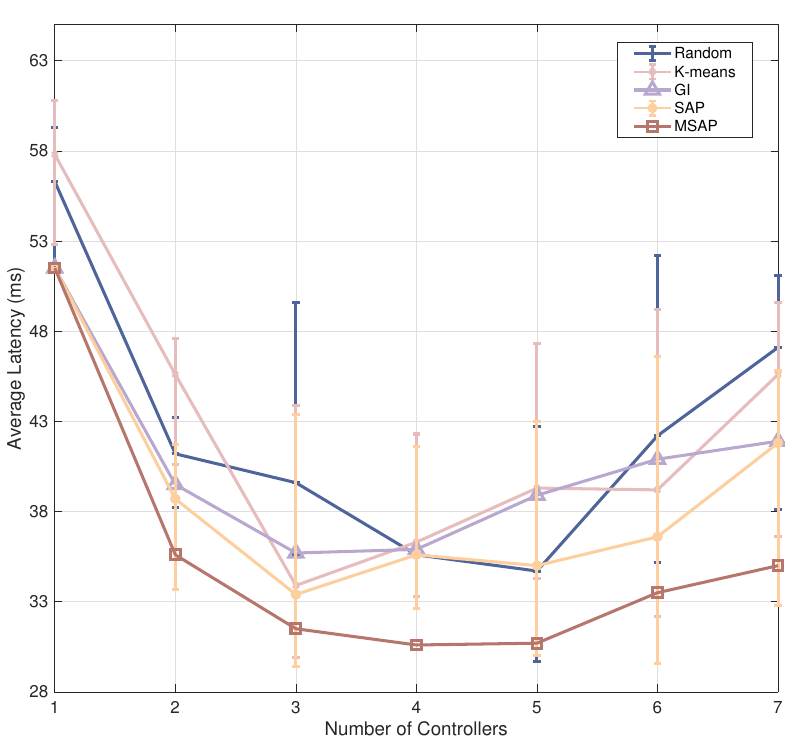
Figure 8. Latency with the different number of controllers in STIN.